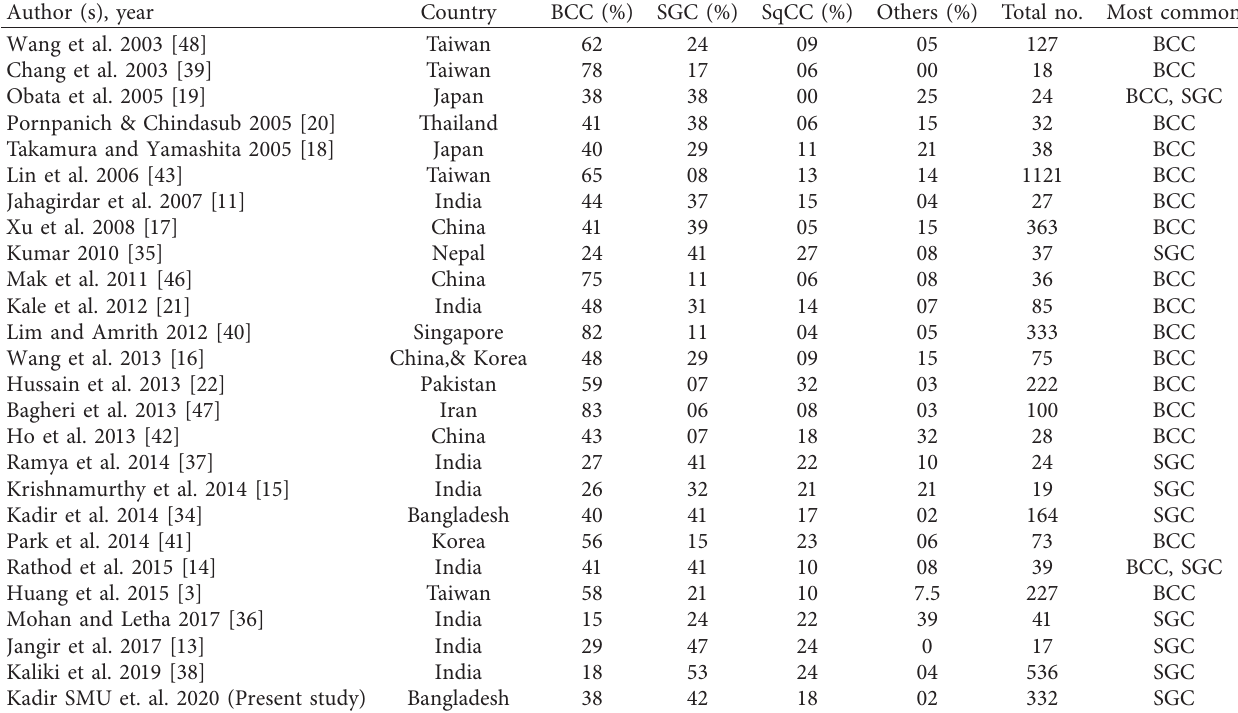
Table 2: Review of the Literatures since 1991 on the ratio of eyelid malignancies in Asian countries. Author (s), year